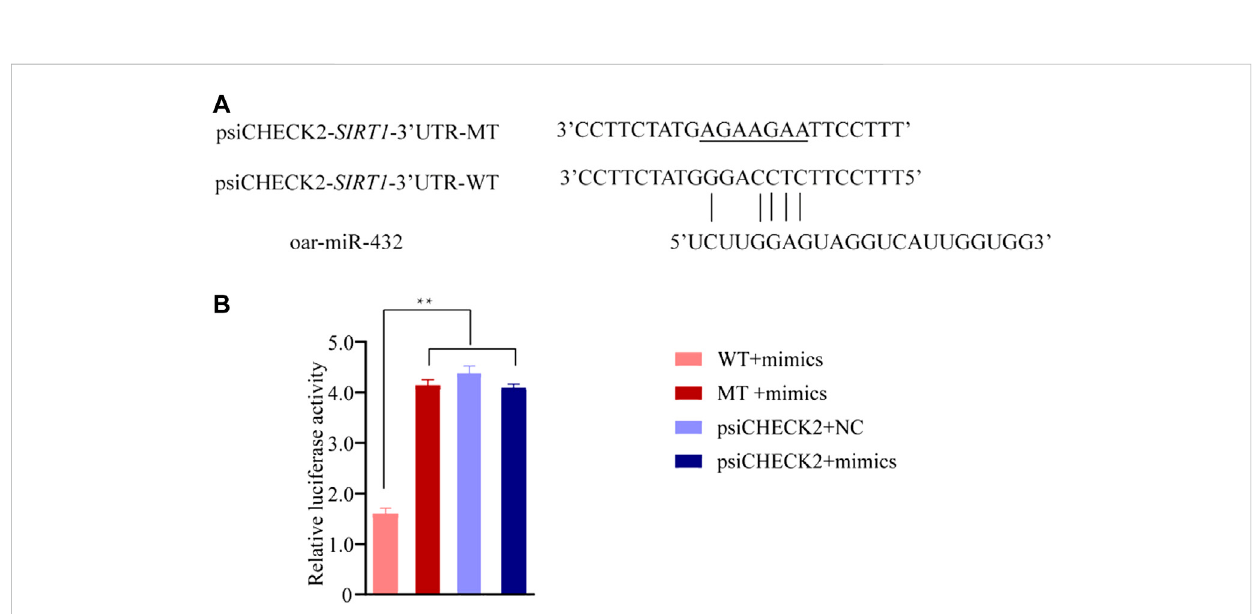
The results of RT-qPCR and Western blot. (A) RNA-Seq and RT-qPCR results of seven differentially expressed miRNAs in ZG compared with HG. (B) RT-qPCR results of SIRT1 in HG and ZG. (C) (D) Western blot results of SIRT1 in preadipocytes. NC exhibits negative